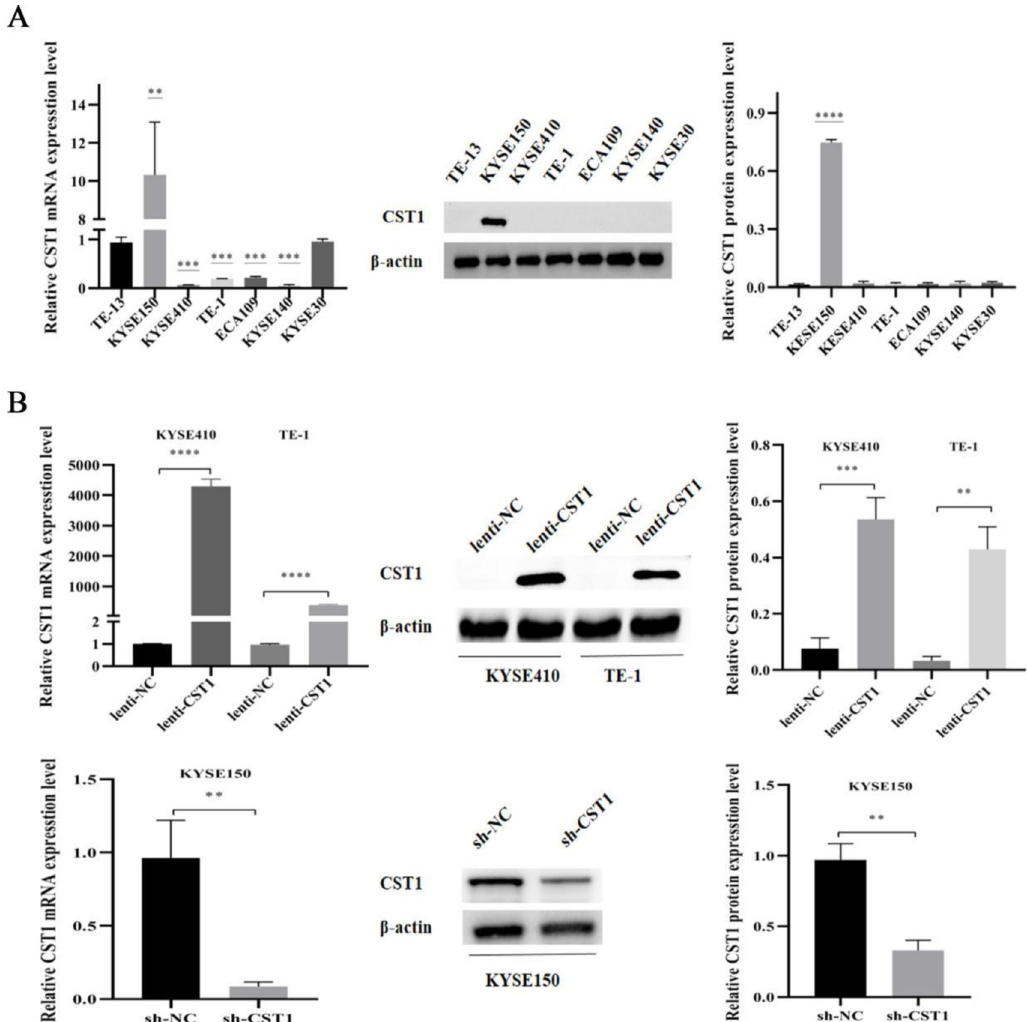
Fig 3. Construction of CST1 overexpression/knockdown cells. (A) CST1 mRNA and protein expression in 7 cell lines (vs TE- 13). (B) mRNA and protein expression of CST1 overexpression/knockdown cells. ( �� P < 0.01, ��� P < 0.001, ���� P < 0.0001). factor Slug, matrix metalloproteinase MMP2, and inhibited the expression of epithelial marker E-cadherin; while CST1 knockdown inhibited the expression of Slug, MMP2, and promoted